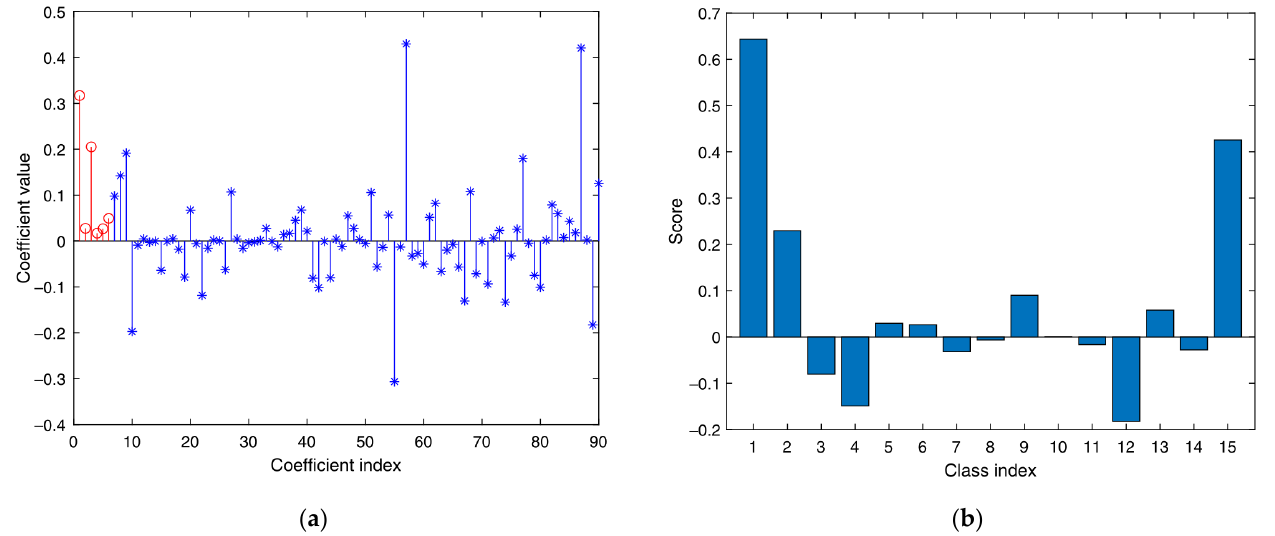
Figure 4. ( a ) Coefficients obtained by the proposed algorithm; ( b ) classification score values obtained by the proposed algorithm.